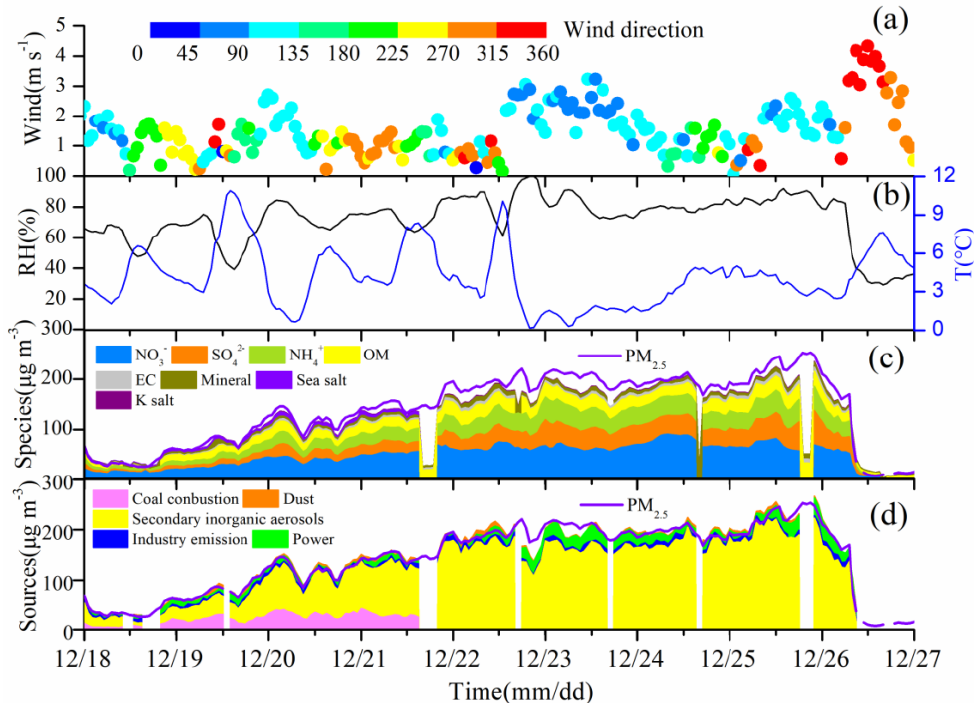
Figure 2. Meteorological conditions ( a , b ), concentration and chemical species of PM 2.5 ( c ), and contributions from each identified source of PM 2.5 ( d ) during 18 − 26 December 2019.